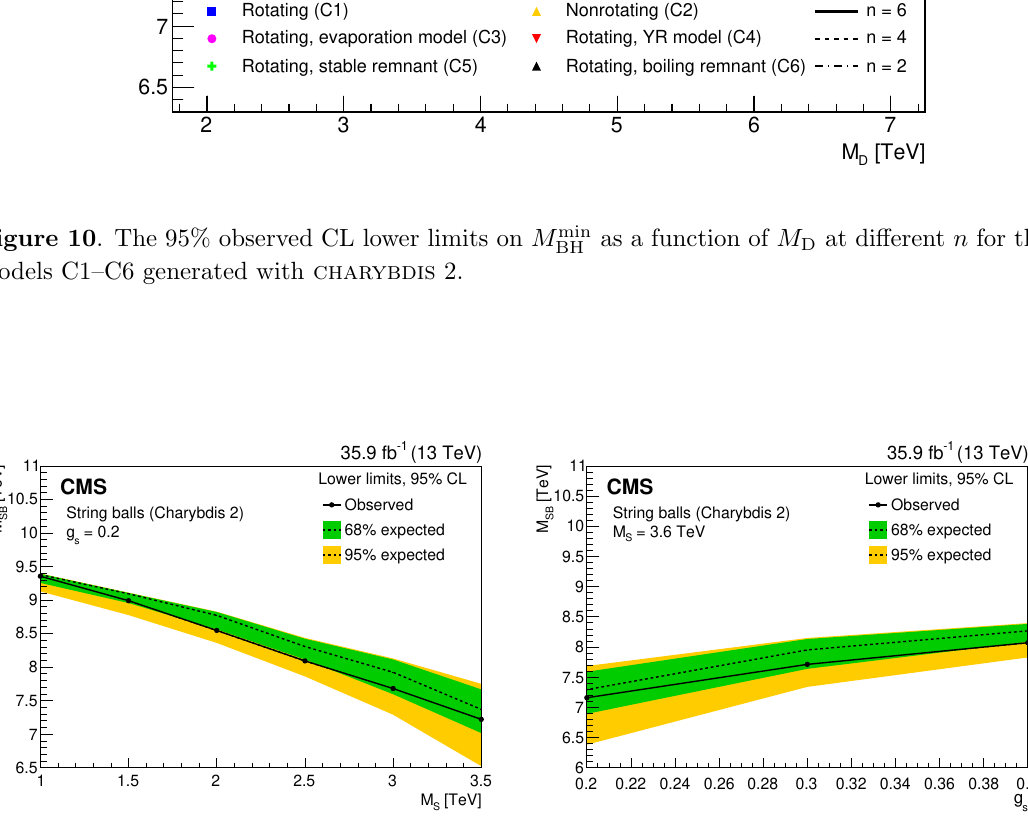
Figure 11 . The 95% CL lower limits on a string ball mass as a function of the string scale M S for a (cid:12)xed value of the string coupling g S = 0 : 2 (left) and as a function of the string coupling g S for a (cid:12)xed value of the string scale M S = 3 : 6 TeV (right). The inner (outer) band represents the (cid:6) 1 ( (cid:6) 2) standard deviation uncertainty in the expected limit. The area below the solid curve is excluded by this